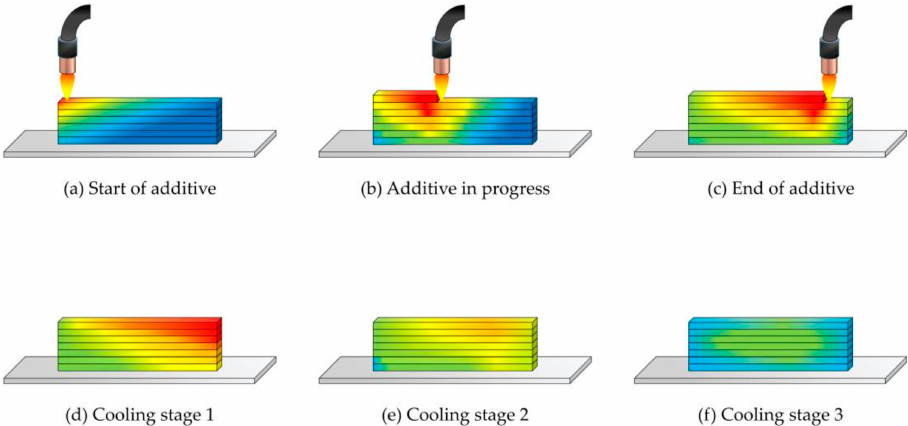
Figure 4. Variation of the temperature field in the process of wire arc additive manufacturing.